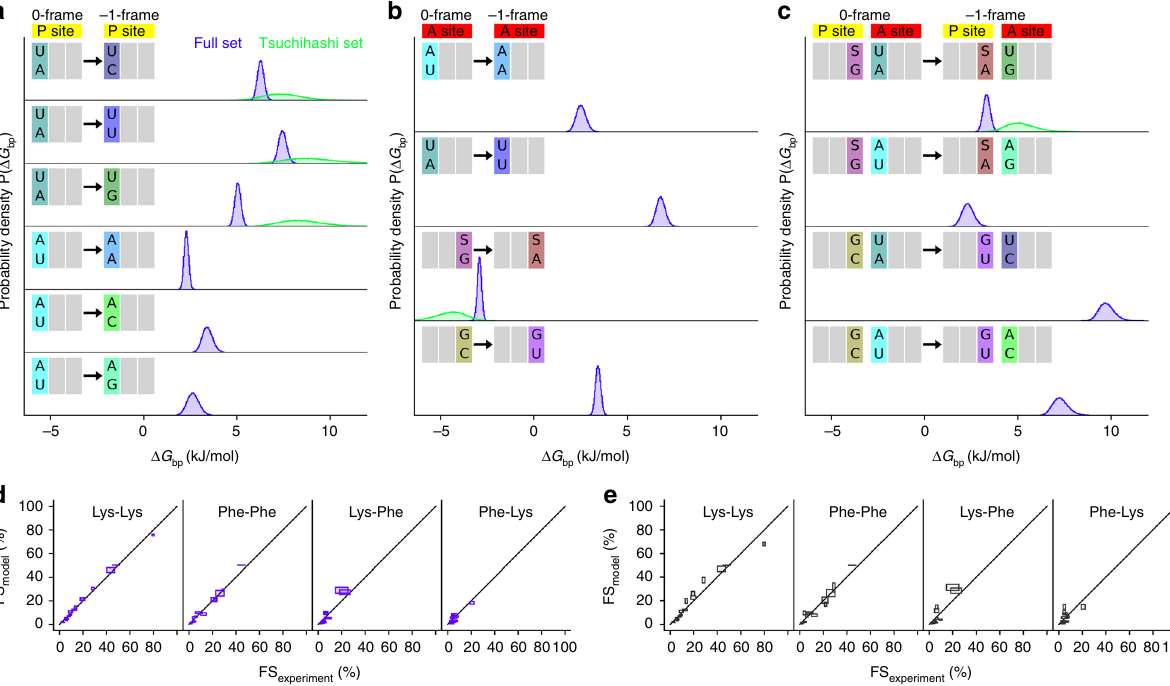
Fig. 2 Inferred mRNA – tRNA base-pair free-energy differences on the ribosome during frameshifting. a Probability densities (colored histograms) of the free-energy differences Δ G bp for the P-site base pairs obtained from the model based on the full FS data set (64 FS values, blue), and a set of the FS values measured in vivo by Tsuchihashi et al. 26 (21 FS values, green). b Probability densities for changing A-site base pairs. c Probability densities for changing P-site and A-site base pairs simultaneously. d FS from experiment compared to that calculated from the free-energy model. Each panel shows FS values for a tRNA pair (rmsd 2.5%). e For cross-validation of the model, iteratively, each FS value was predicted using free-energy differences obtained from all other FS values (rmsd 4.1%). For each mRNA sequence, one square is centered at the mean value and the width and height correspond to two times the